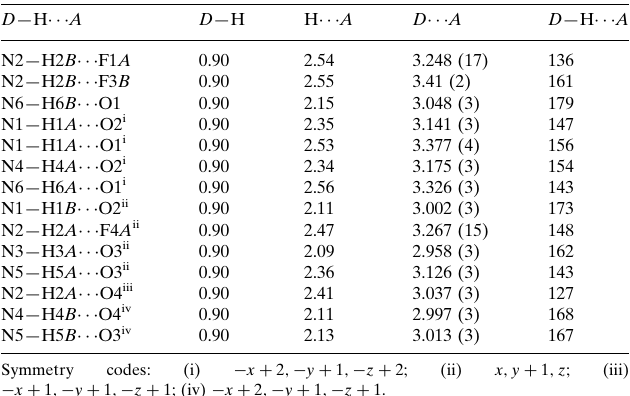
Hydrogen-bond geometry (A˚ , (cid:2)